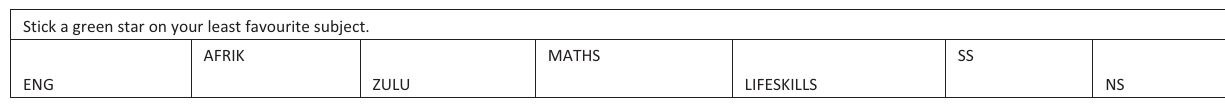
Stick a green star on your least favourite subject.